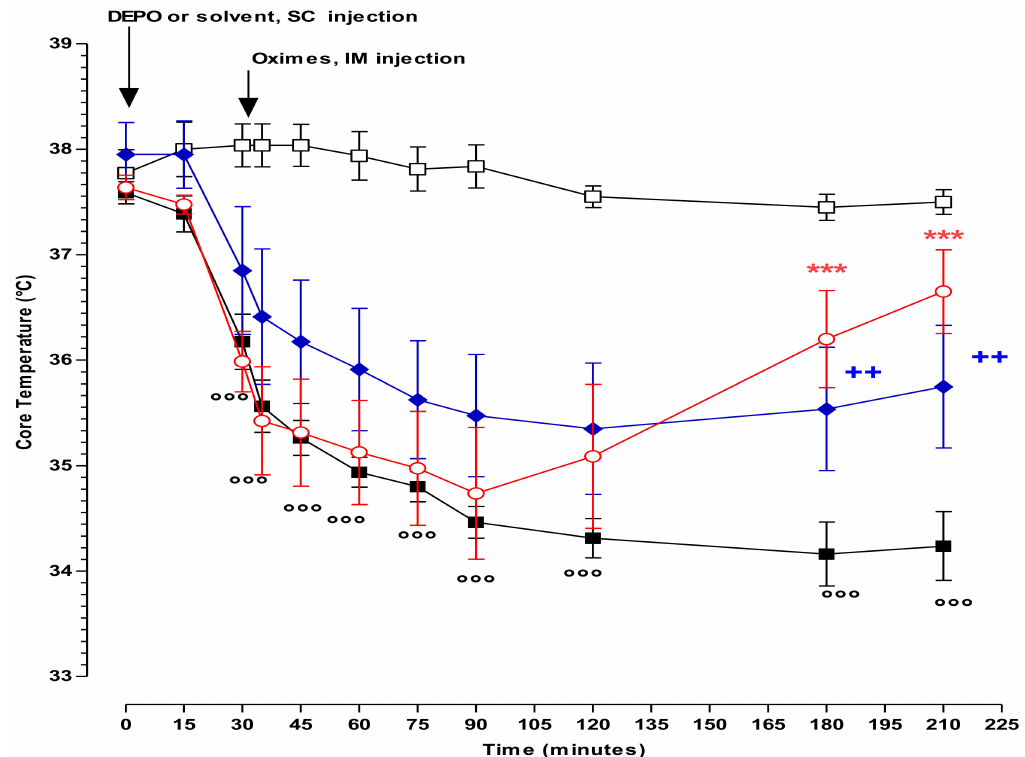
Figure 2. E ff ects of solvent (white square), diethyl-paraoxon (DEPO, black square), diethyl-paraoxon + pralidoxime (DEPO + PRX, blue diamond), and diethyl-paraoxon + BI-6 (DEPO + BI-6, open red circle) on core temperature. Arrows mark the injection time of solvent or DEPO and PRX or BI-6. Each group consisted of eight rats. Data are represented by mean ± S.E.M. at each time after injection. DEPO vs. Control: ◦◦◦ p < 0.01; DEPO + BI-6 vs. PRX: ++ p < 0.001; DEPO + BI-6 vs. DEPO: *** p < 0.001.